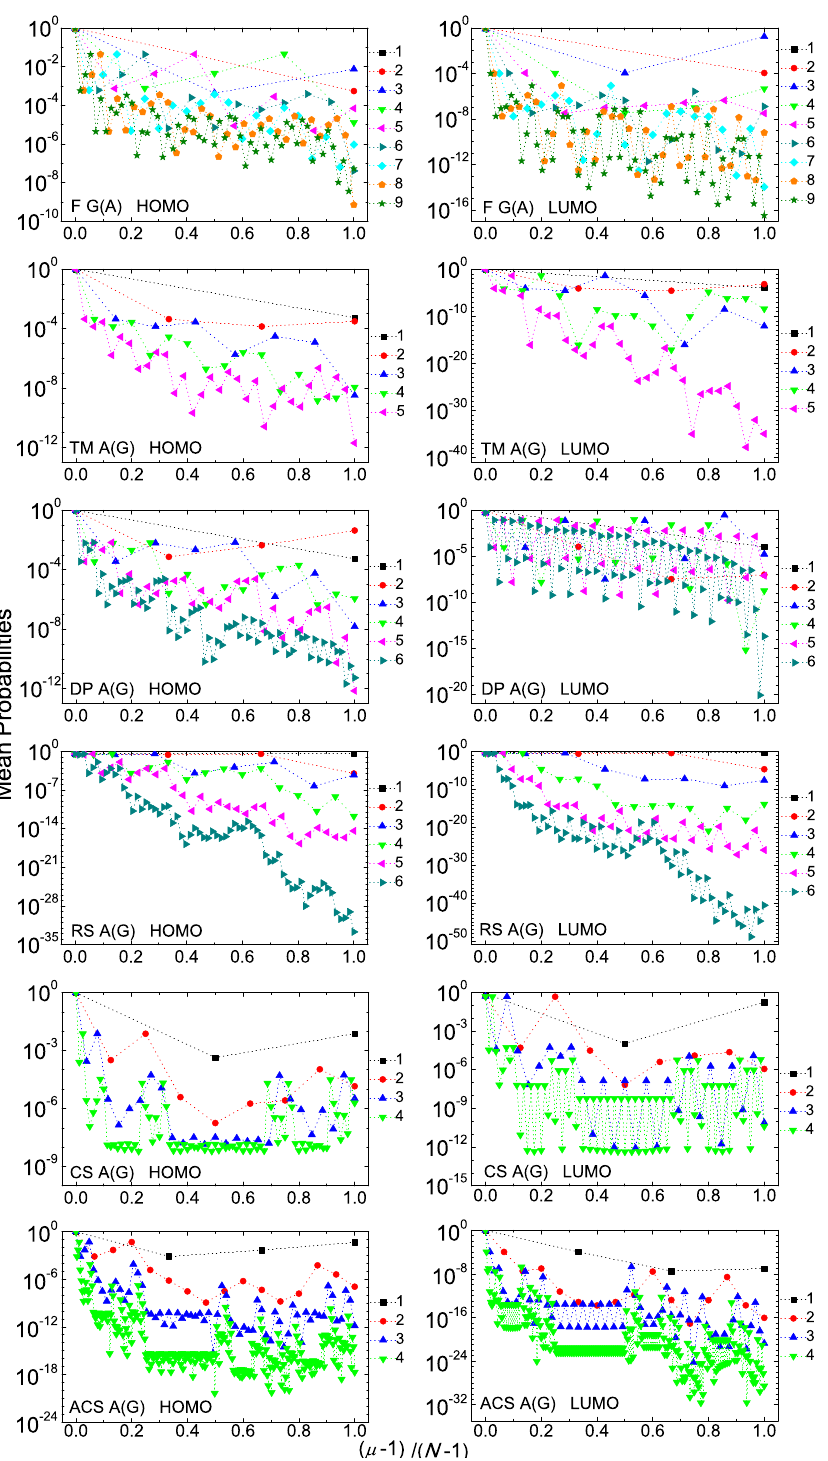
Figure A2. Mean over time probabilities to find the extra carrier at each monomer µ = 1,. . ., N , having placed it initially at the first monomer, for some consecutive generations, for F G(A), TM A(G), DP A(G), RS A(G), CS A(G), ACS A(G) polymers, for the HOMO (left column) and the LUMO (right column). The notation of polymers is given in Table